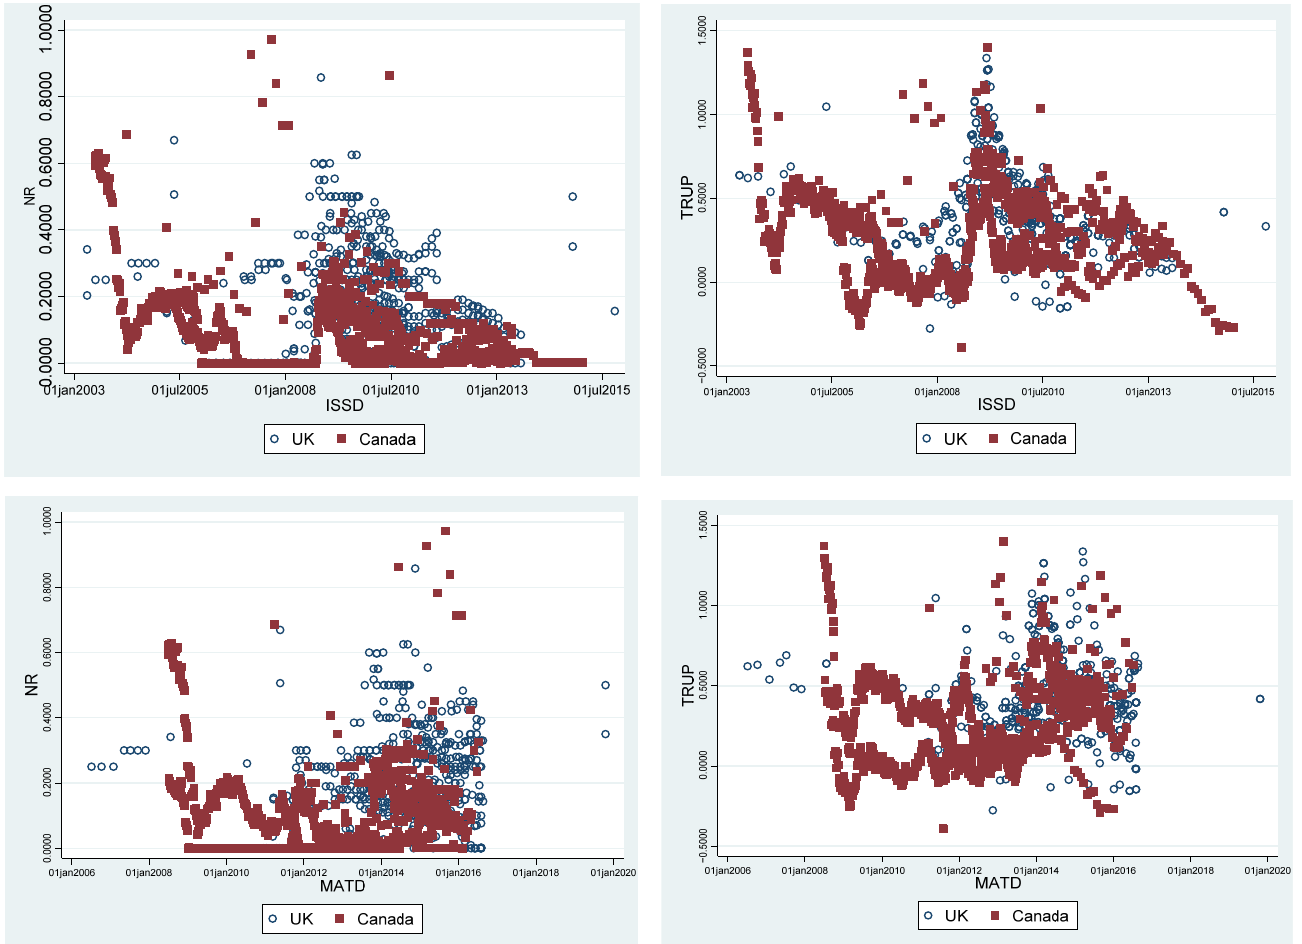
Figure 2. The structured product return R SP ( NR ) and the underlying portfolio total return R UP ( TRUP ) by issue date ( ISSY ) and maturity date (MATD ).